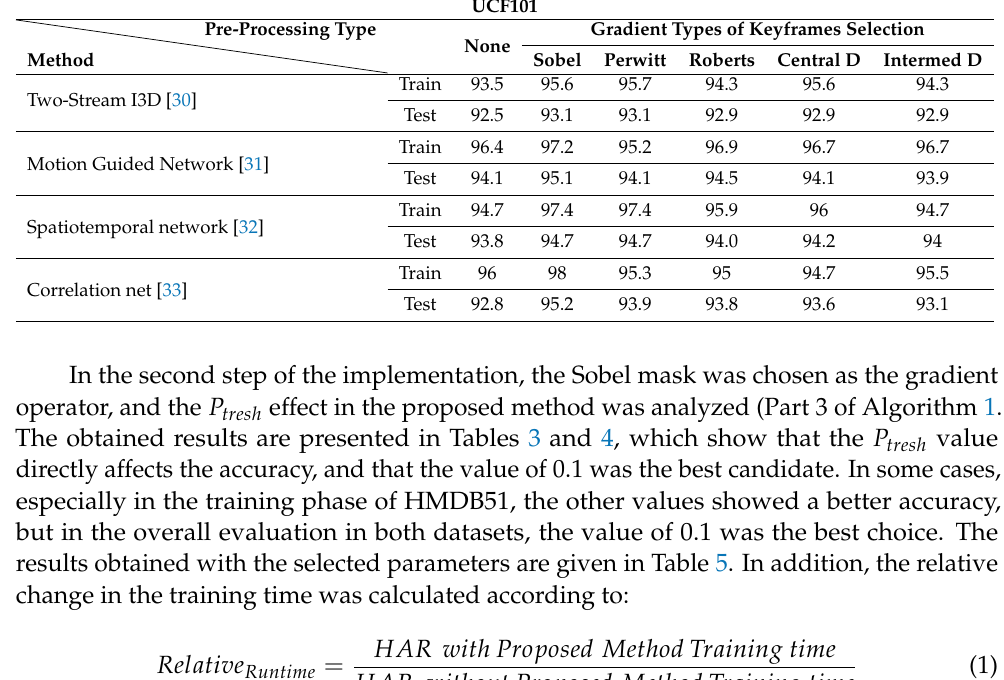
Table 2. Accuracy of the Train and Test data in the UCF101 dataset versus Gradient types (D—difference).